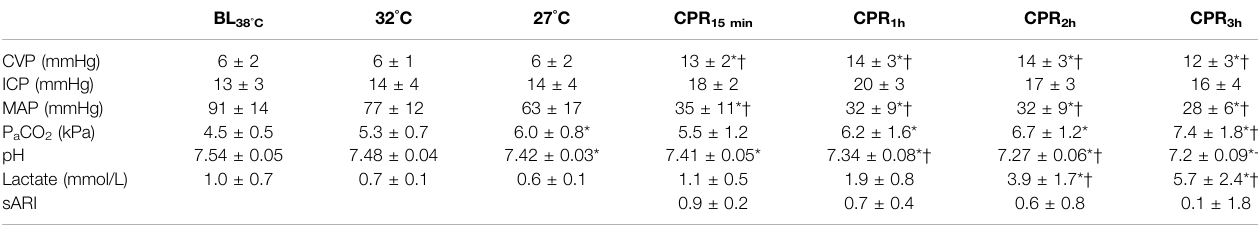
TABLE 1 | Values are mean ± SD ( n = 8).